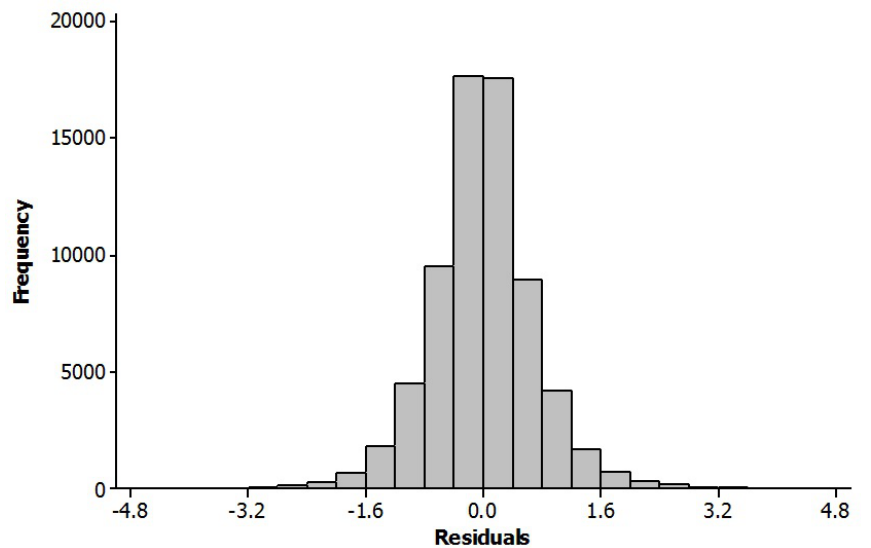
Figure 10. Error histogram for the ARIMA model in